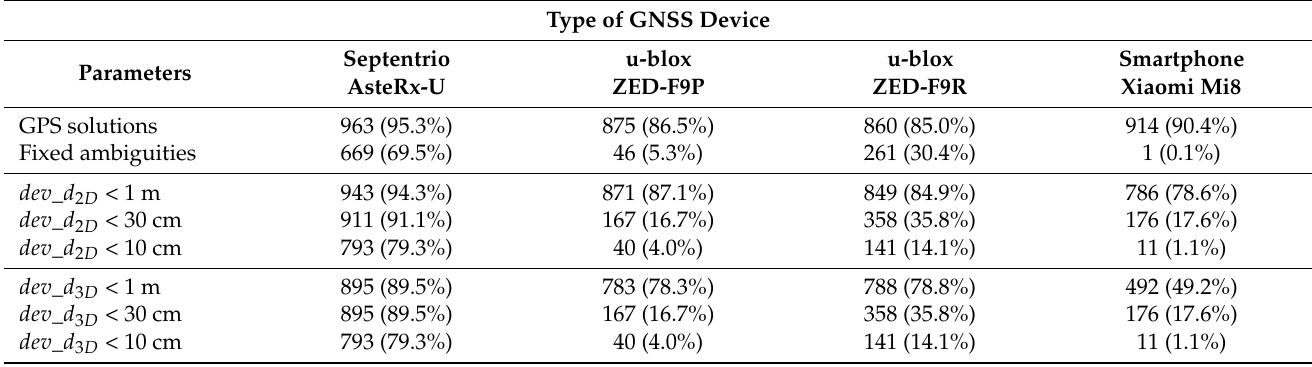
Table 13. GPS solutions, solutions with fixed ambiguities, and deviation of distances below the given threshold. Situation Case D—open sky conditions with vegetation by the roadside (no. of total: 1001).